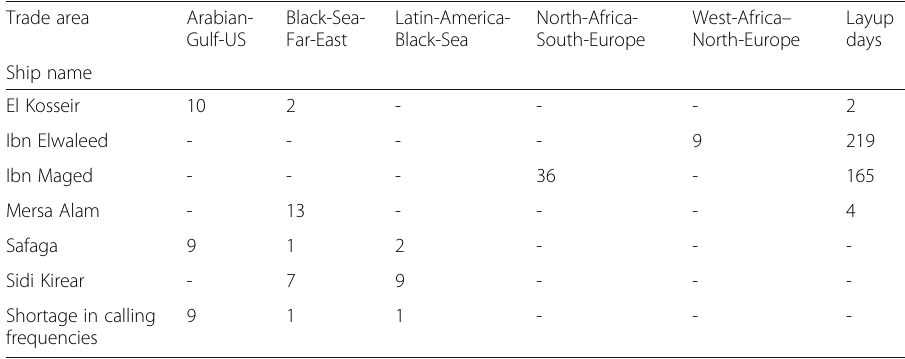
Table 14 Optimal fleet calling frequencies in 2018, classified by ship and trade area Trade area